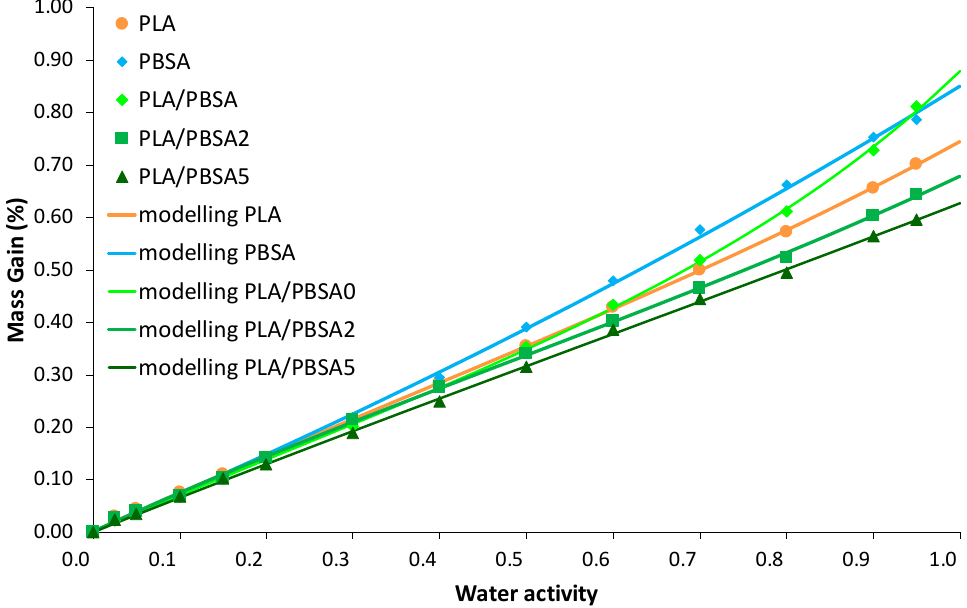
Figure 11. Water vapor sorption isotherms for the PLA / PBSA, PLA / PBSA2 and PLA / PBSA5 multilayer films modelled by two consecutive sorption modes, the Henry-law sorption and the aggregation (clustering) sorption, as represented in Equation (9).